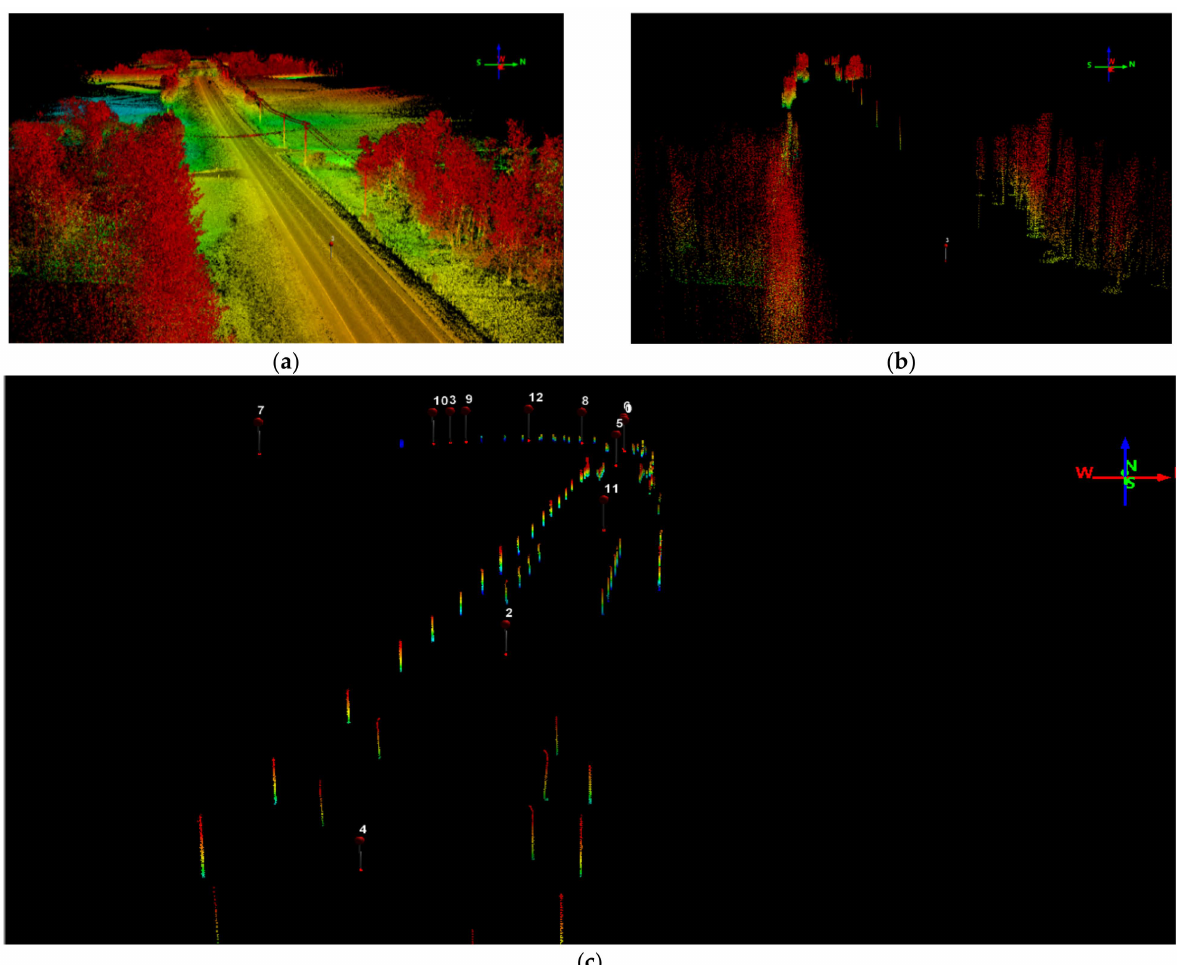
Figure 4. Non-ground objects: ( a ) full-segment; ( b ) tree canopy; ( c ) pole-like